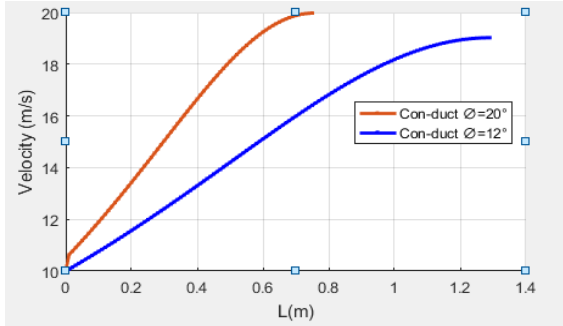
Fig. 5. Velocity distribution along the different convergent duct